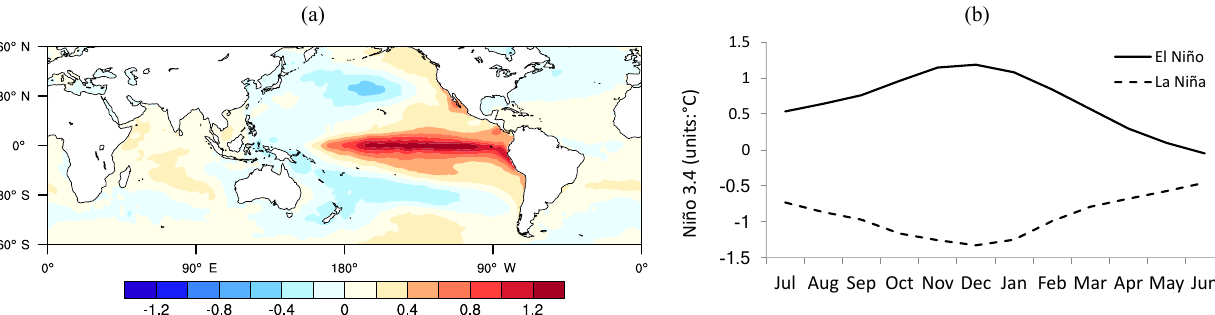
Figure 1. (a) Typical ENSO mode (units: ◦ C/ ◦ C) and (b) average monthly Niño3.4 (units: ◦ C) of 21 El Niño and 18 La Niña events from 1951 to